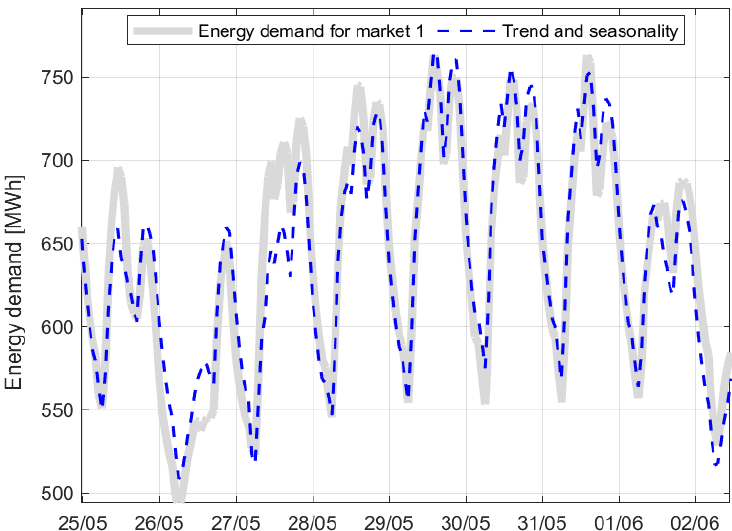
Figure 3. Daily energy demand for Market 1 between 25 May 2018 – 2 June 2018.